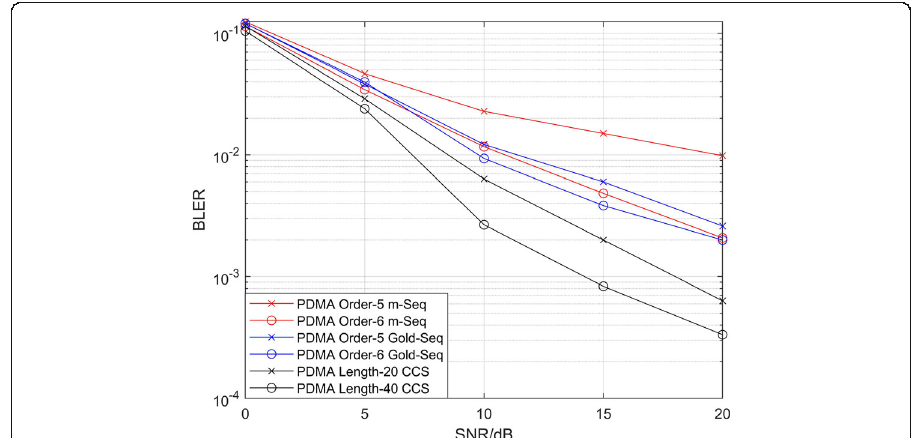
Fig. 10 Performance comparison of three spread spectrum sequences under water-filling power allocation.